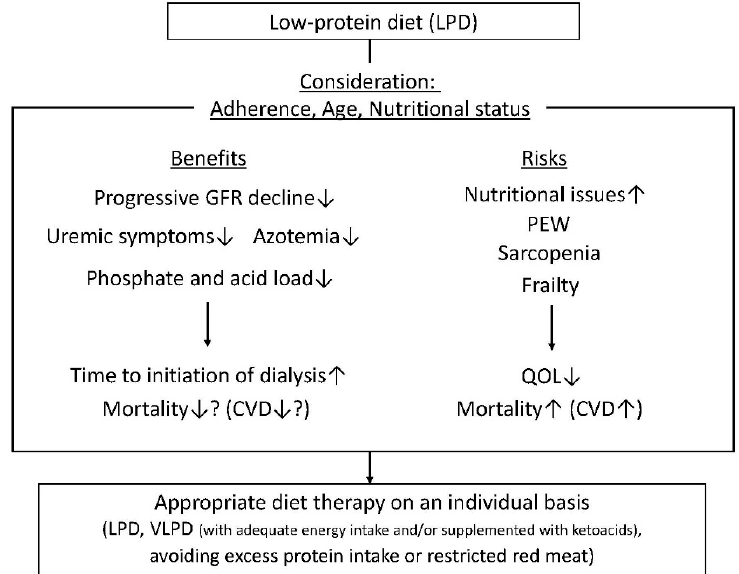
Figure 2. The benefits of a low-protein diet (LPD) in chronic kidney disease (CKD) patients include slowing the progression of renal function decline, a decrease in uremic symptoms and azotemia, and reductions of phosphate and acid loads, resulting in an extension of time for the initiation of dialysis and possibly reduced mortality, particularly for cardiovascular disease (CVD). The risks of an LPD include nutritional issues, including protein–energy wasting (PEW), sarcopenia and frailty. This results in a reduction of quality of life (QOL) and increased mortality due to increased CVD. Therefore, an LPD should be prescribed to patients with CKD, including diabetic kidney disease (DKD), with consideration of a patient’s adherence, age and nutritional status. Appropriate diet therapy should be evaluated on an individual basis (LPD, VLPD with adequate energy intake and/or supplemented with ketoacids, or avoidance of excess protein intake or restricted red meat).